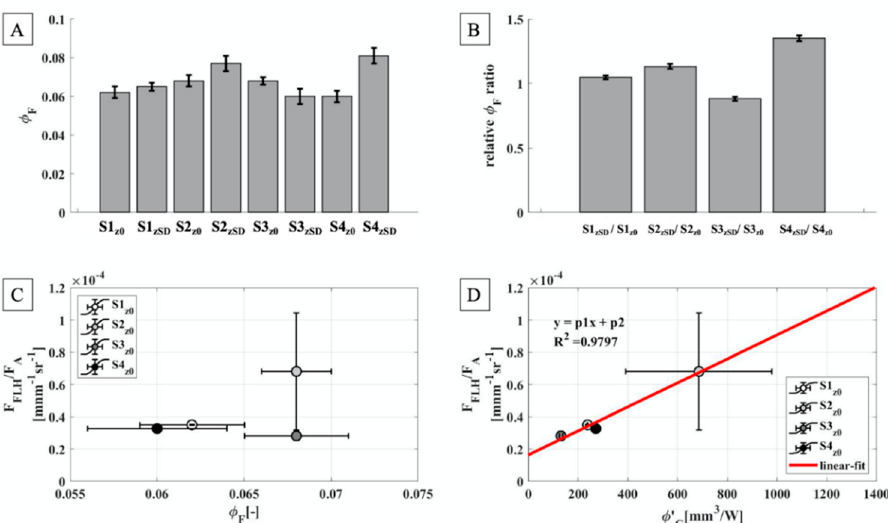
Figure 6. ( A ): Φ F values obtained from the laboratory analysis referred on both z 0 and z SD . ( B ): relative Φ F ratio. Values linked to the Secchi Disk depth were divided by the corresponding surface values. ( C , D ): the comparison between the F FLH /F A ratio with the Φ F and Φ ’ C . Values displayed in the lower panels, correspond to measurements evaluated at the surface only. All the measurements displayed here correspond to mean values, while the error bars to the standard deviations. ( D ): S2 z0 is characterized by a high uncertainty both on the x and y axes, probably due to the light variability during the measurements acquisition accounted the E d term.